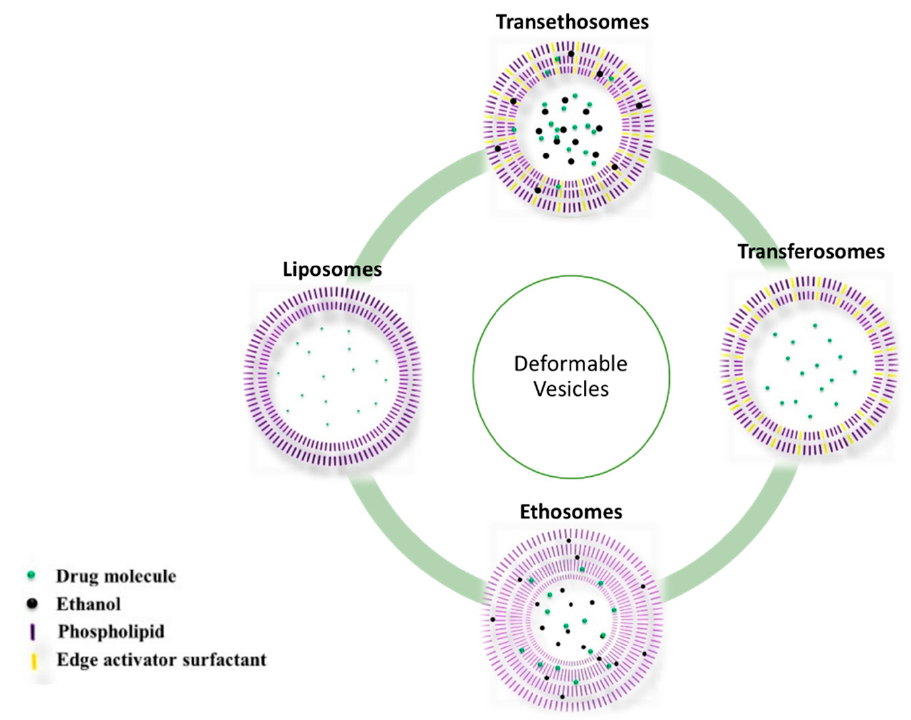
Figure 4. Schematic representation of the different types of vesicular carriers, with defined layers and compositions. Adapted with permission from [88].